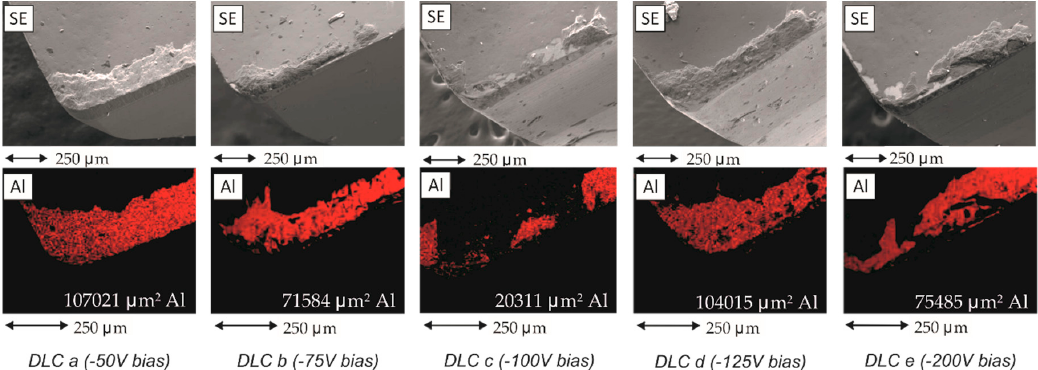
Figure 10. Aluminium element mapping images of the flank face of mill insert with DLC coating after Figure 10 face milling AlSi alloy. Element mapping obtained with EDX mode of